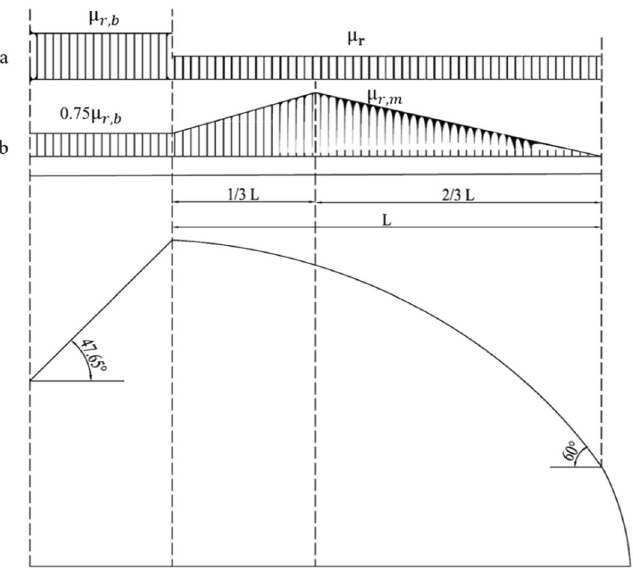
Figure 5. Snow distribution coefficient on the solar greenhouse roof: ( a ) uniform distribution; ( b ) uneven distribution.